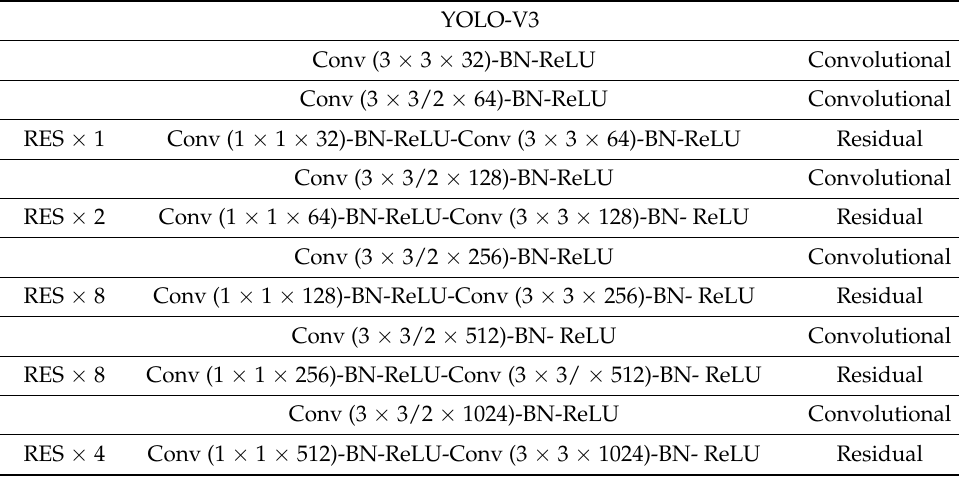
Table 3. The feature extraction network’s parameters of original YOLO-V3.